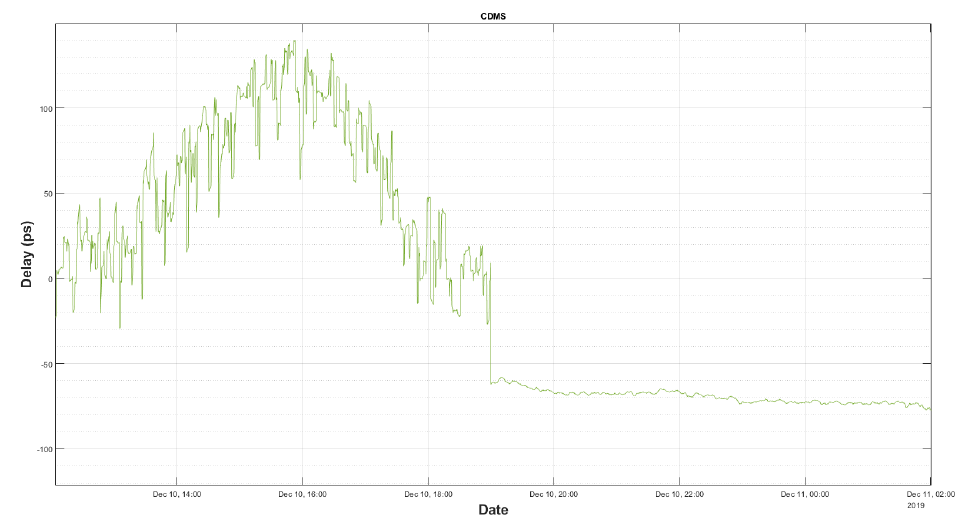
Figure 17. Measured delay during and after radio telescope movement.